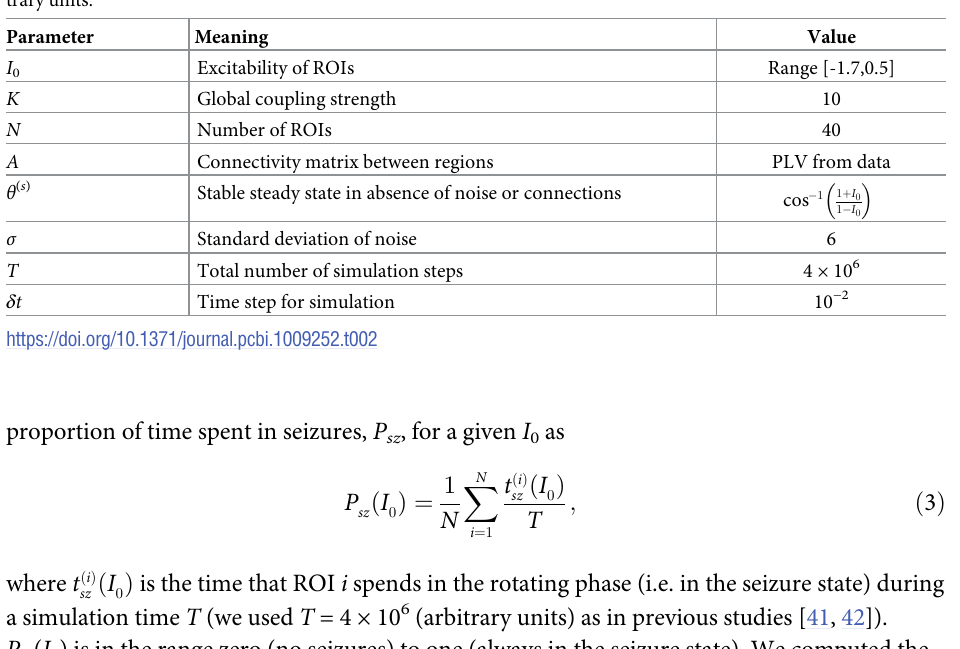
Table 2. Parameters, their meanings, and their standard values used in the simulations. All parameters have arbi- trary